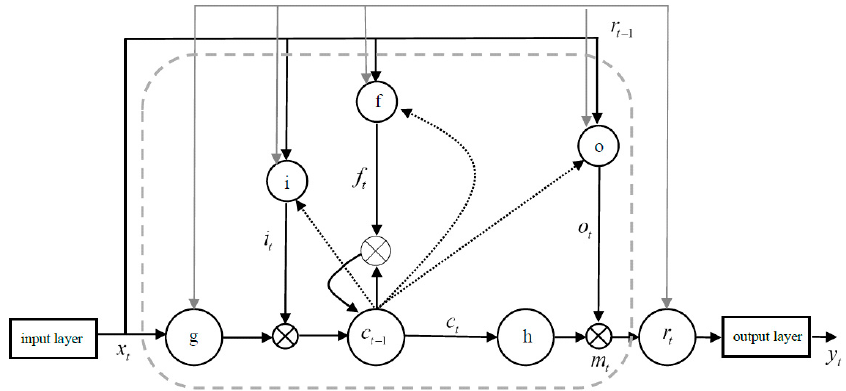
Figure 5. Long short-term memory neural network (LSTM).